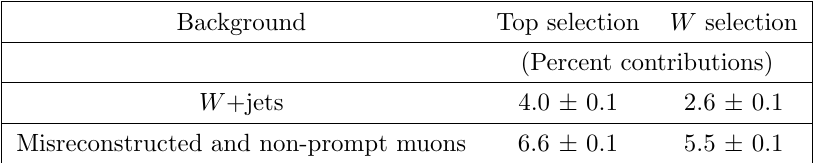
Table 3 . Contributions from background processes which are subtracted in the top and W selec- tions. The uncertainties are statistical